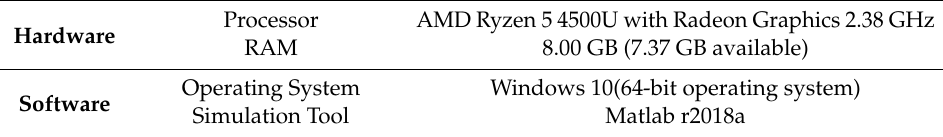
Table 1. The software and hardware configuration.